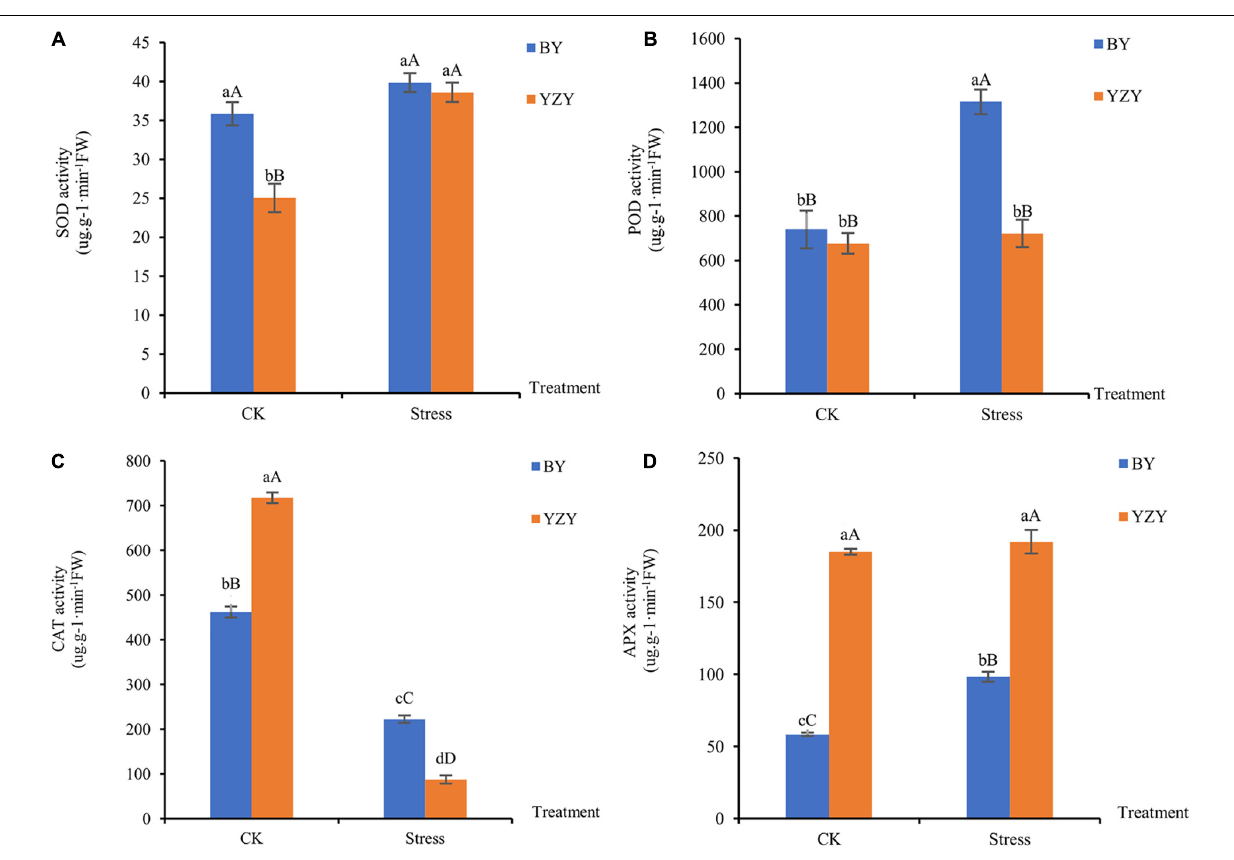
FIGURE 3 | Antioxidant enzyme activity of oat seedling roots during CK and saline-alkali stress conditions. (A) Activity of superoxide dismutase, (B) activity of peroxidase, (C) activity of catalase, and (D) activity of ascorbate peroxidase. FW, fresh weight; DW, dry